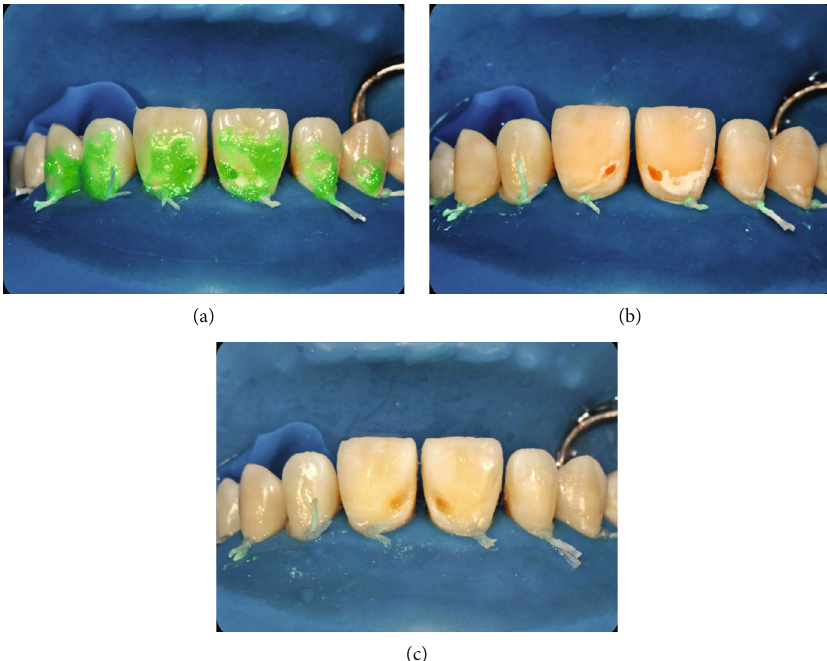
Figure 3: Resin in fi ltration technique steps: application of (a) Icon-Etch, (b) Icon-Dry, and (c) Icon-In fi